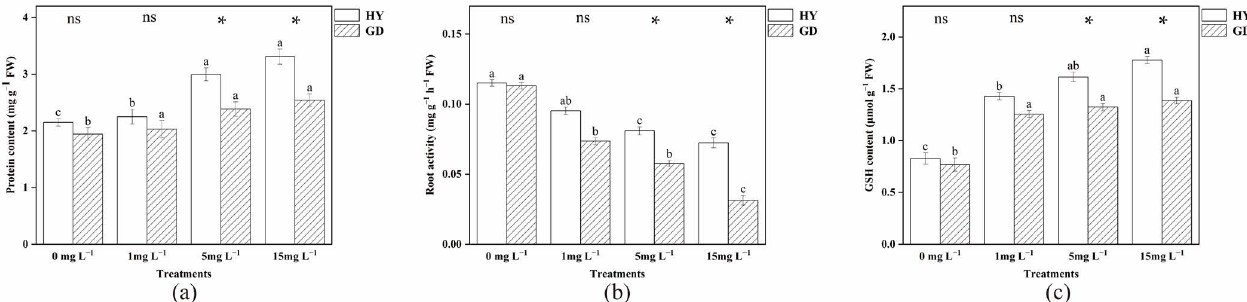
Figure 3. Root protein content ( a ), root activity ( b ), and GSH content ( c ) of two Chinese flowering cabbage under different doses of As. * indicates significant ( p < 0.05) differences between two cultivars at the same As treatment by t -test.